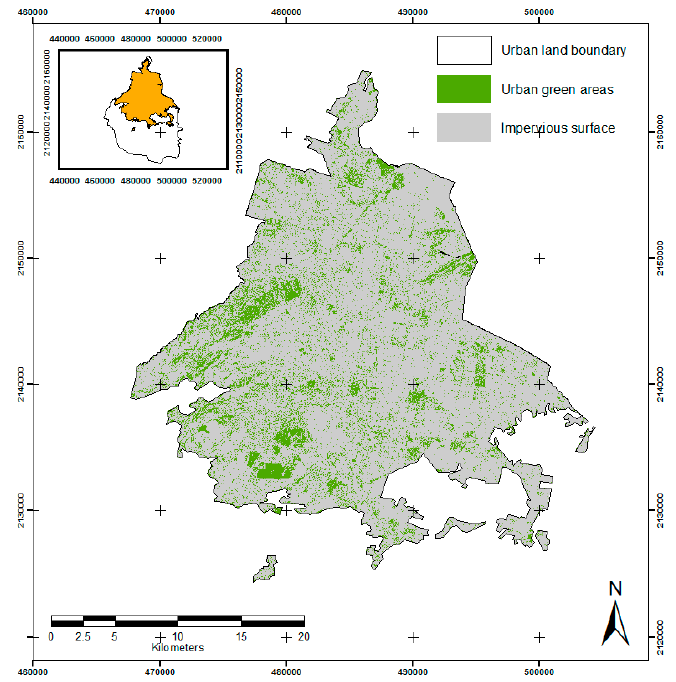
Figure 5. Green area vs. impervious surface in Mexico City. Table 5. Green area surface vs. impervious surface (grey surface) in Mexico City’s boroughs.